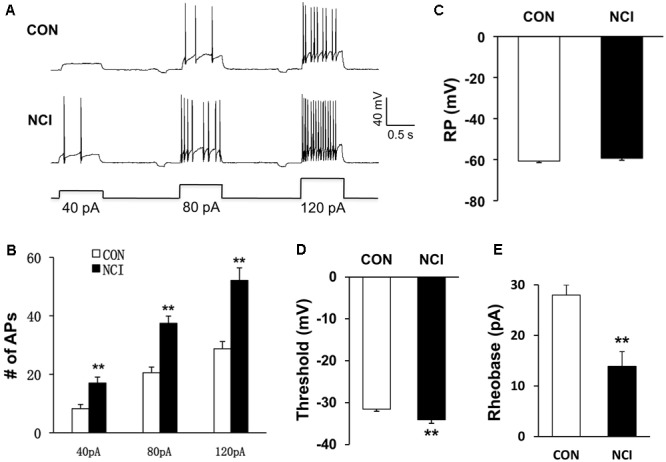
NCI increased the excitation of SG neurons. (A) Representative traces of APs caused by three different depolarizing current stimulation (40, 80, and 120 pA) in SG neurons from CON and NCI rats. (B) NCI greatly increased the frequency of APs elicited by current injection of 40, 80, and 120 pA compared with controls. n = 17 for control group and n = 18 for NCI group, ∗P < 0.05 vs. CON, ∗∗P < 0.01 vs. CON. (C) The mean resting membrane potential (RP) had no significant difference between CON and NCI rats (n = 59 for control group and n = 33 for NCI group). (D) There was significant hyperpolarization in action potential (AP) threshold between CON and NCI rats. n = 35 for control group and n = 20 for NCI group, ∗∗P < 0.01. (E) NCI significantly decreased the rheobase when compared with CON. n = 35 for control group and n = 20 for NCI group, ∗∗P < 0.01.